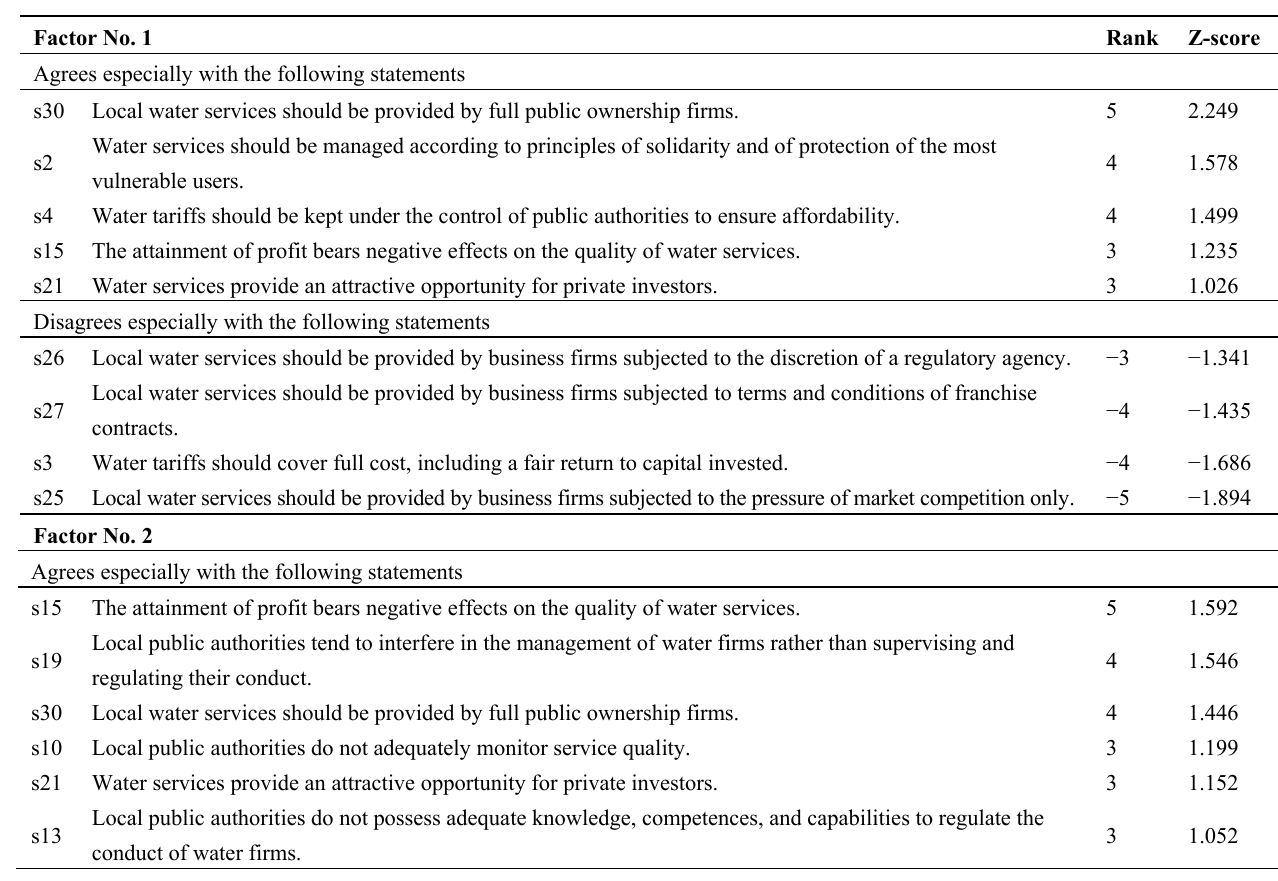
Table 6. Defining statements for each factor (Z-scores greater than 1 or lower than